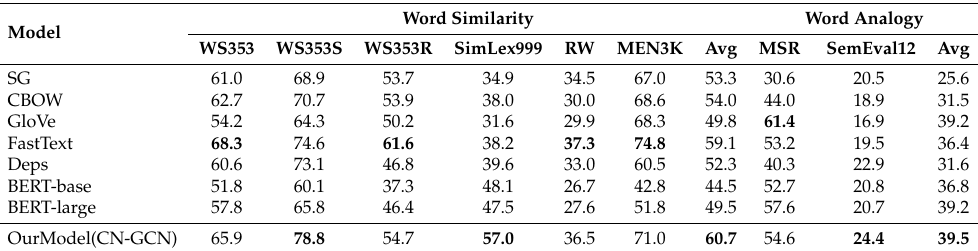
Table 1. Task performance in the word similarity and word analogy domains on word embedding benchmarks. The overall performance for each domain is also presented as an average. The highest performance among the models is indicated in